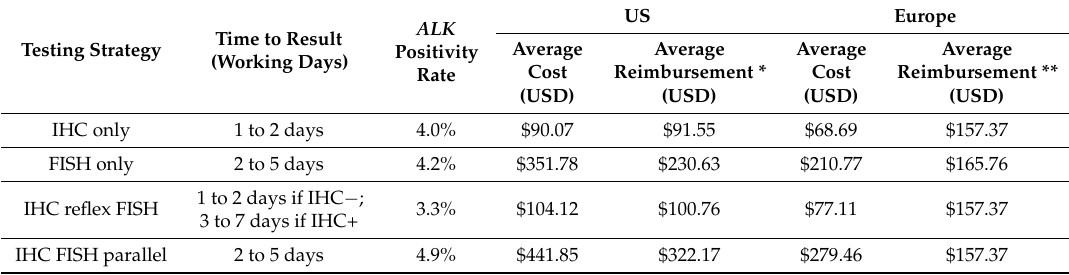
Table 2. Results summary from the cost-impact model (all costs in 2015 United States